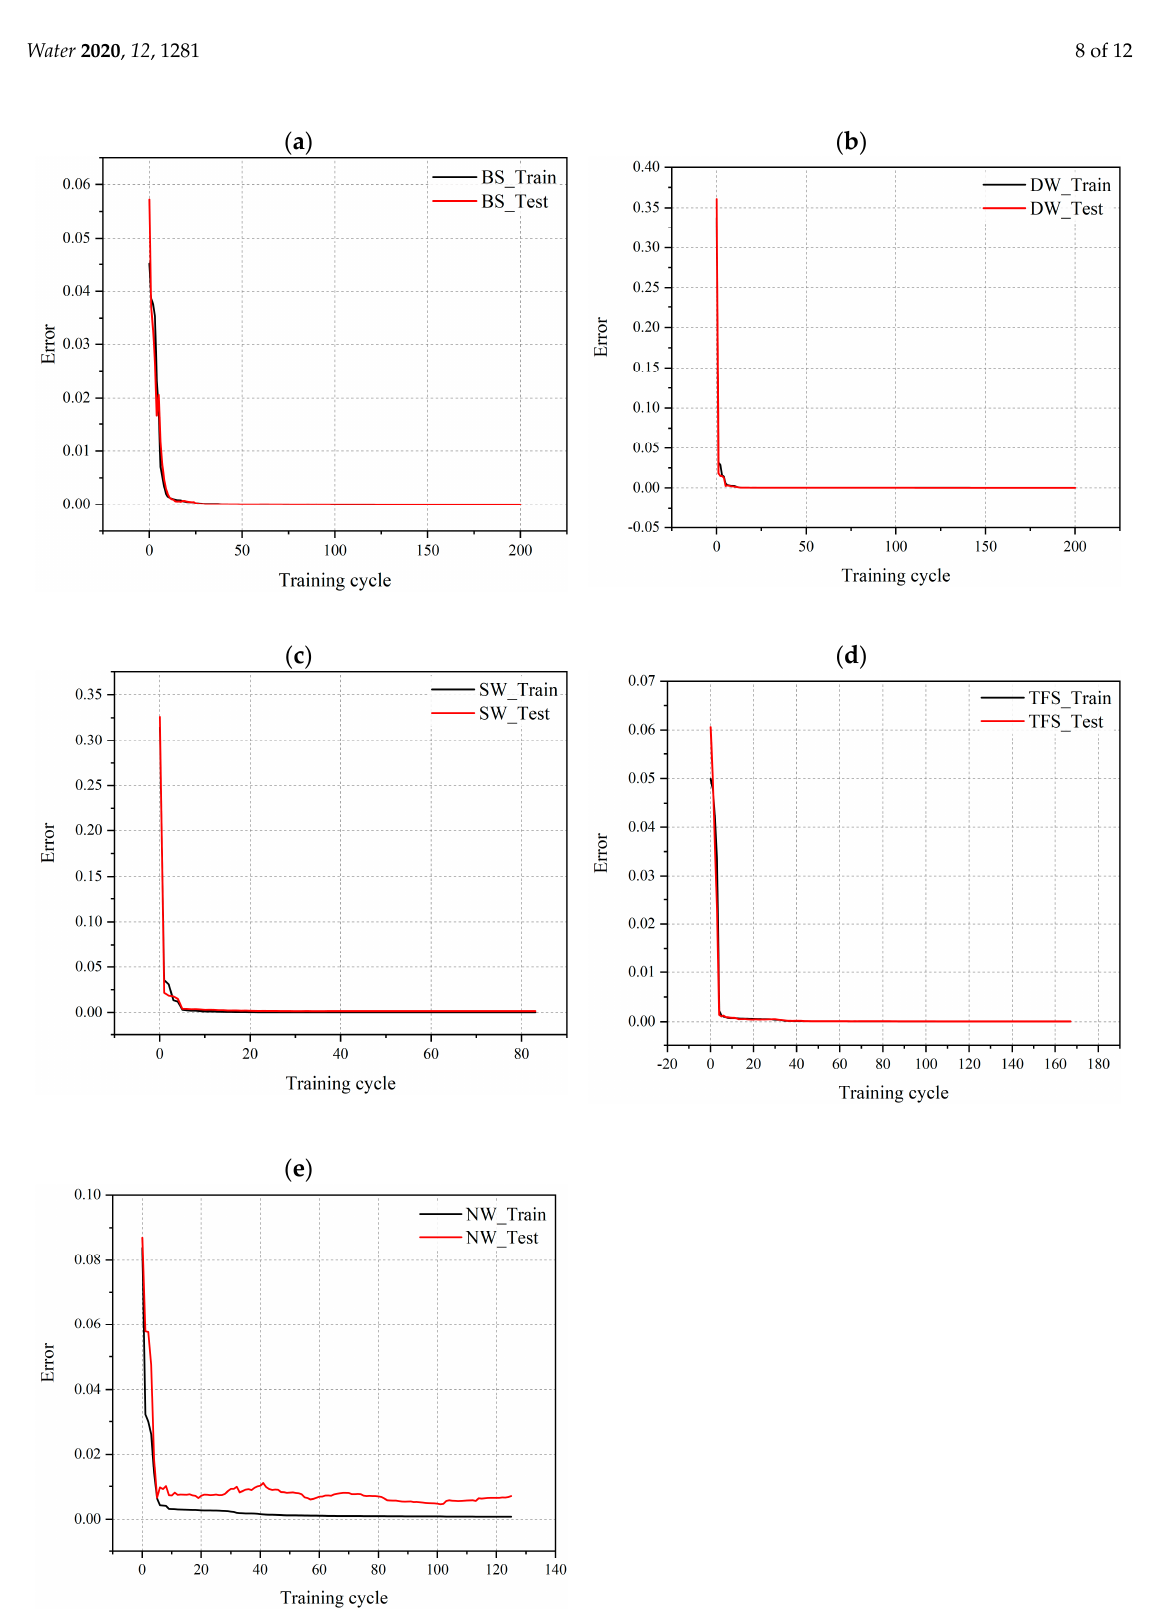
Figure 4. Training cycles and errors of the different activation functions. Figure 4. ( a – e ) Training cycles and errors of the di ff erent activation